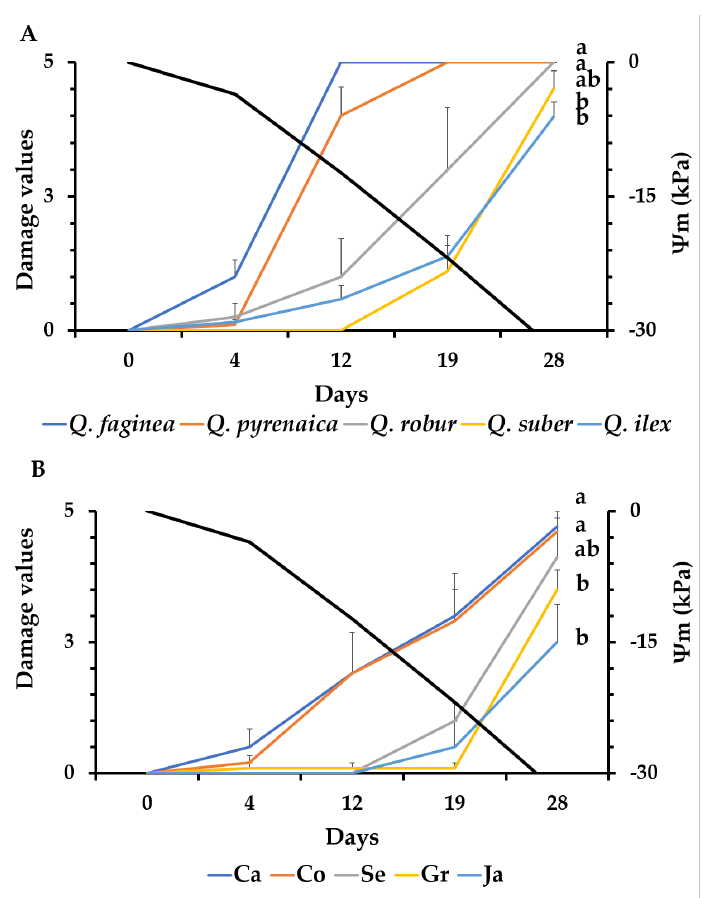
Figure 1. Damage symptoms in drought-stresses seedlings of Quercus spp. ( A ) and Q. ilex